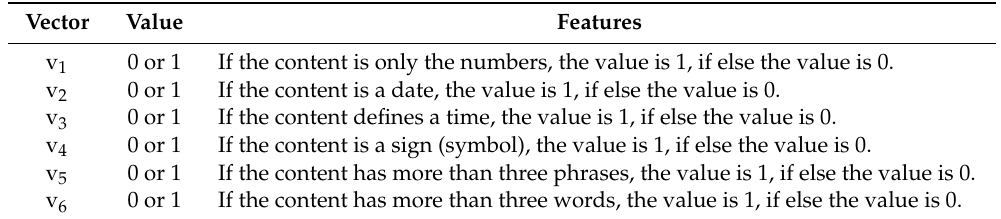
Table 3. Description of data type and text feature vector representation.